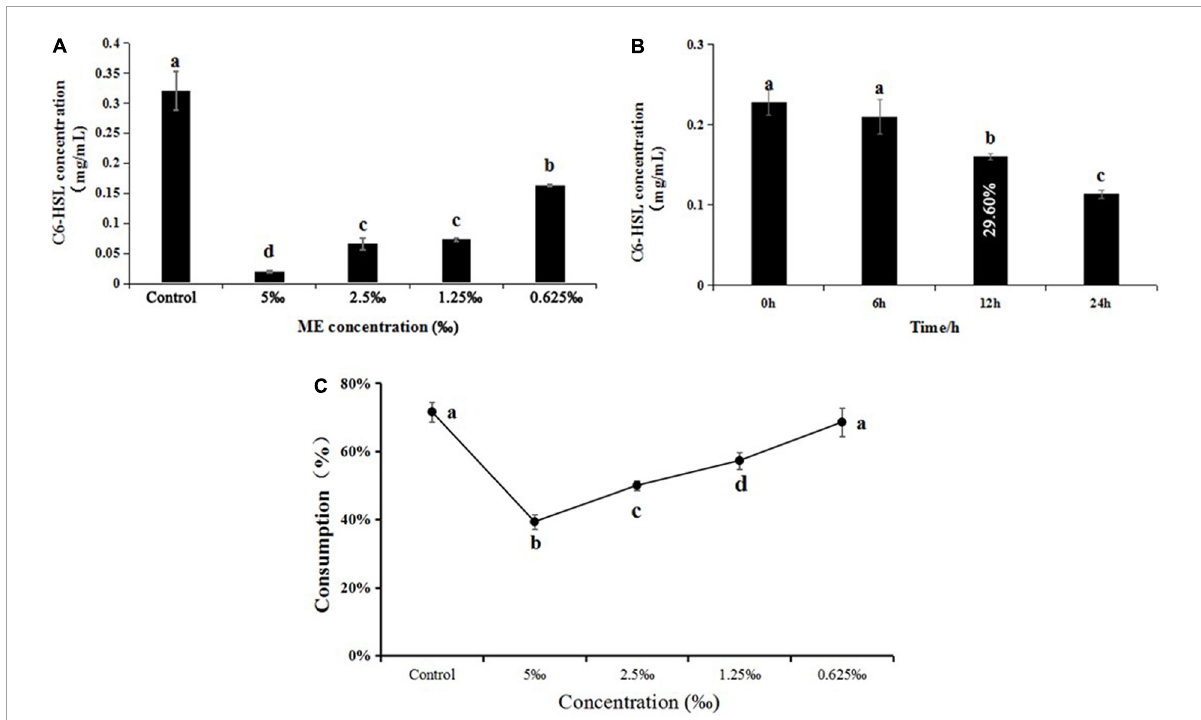
FIGURE5 (A) Effect of methyleugenol (ME) at different concentration (5, 2.5, 1.25, and